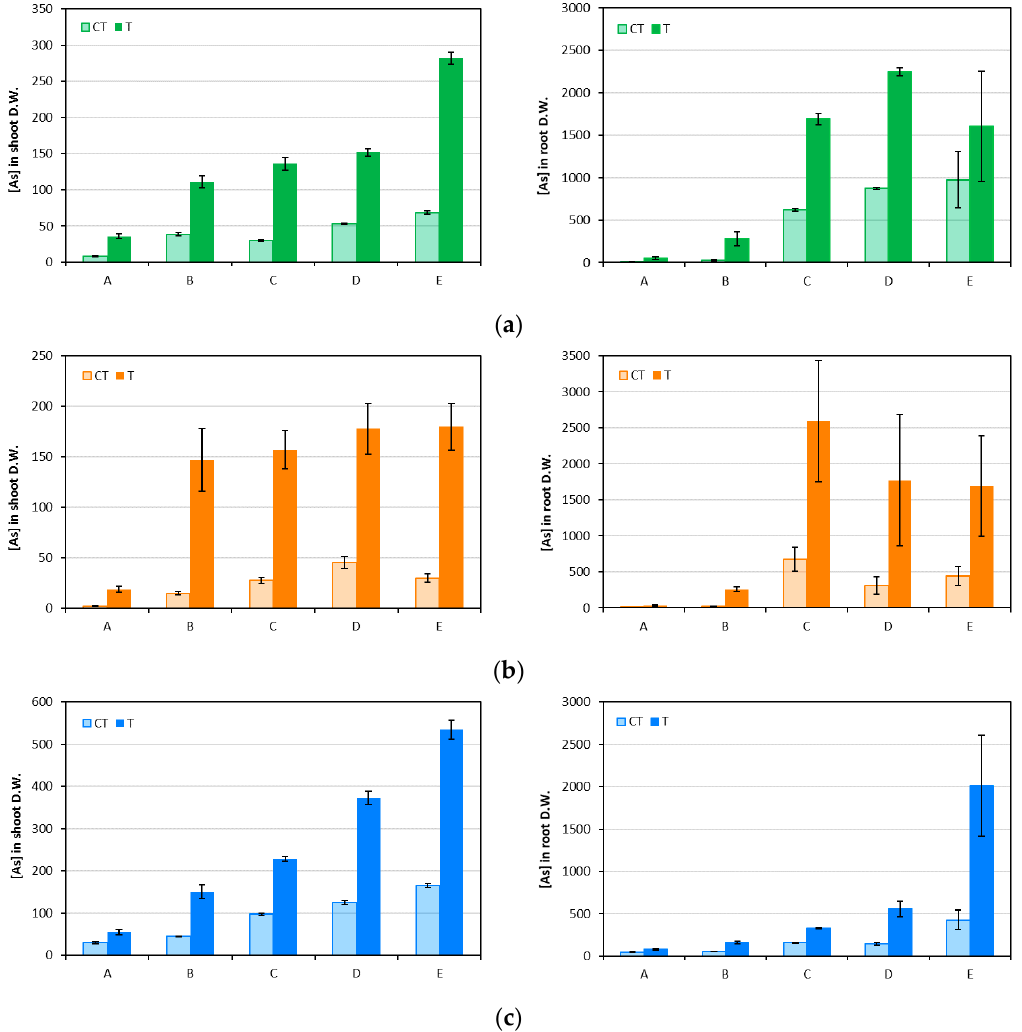
Figure 1. The effect of phosphate addition on As accumulation in shoots and roots of B. juncea ( a ), L. albus ( b ), and H. annuus ( c ) grown in contaminated soils with different As concentrations. Values are concentration in mg · kg − 1 on a dry weight basis expressed as mean ± SD (n =